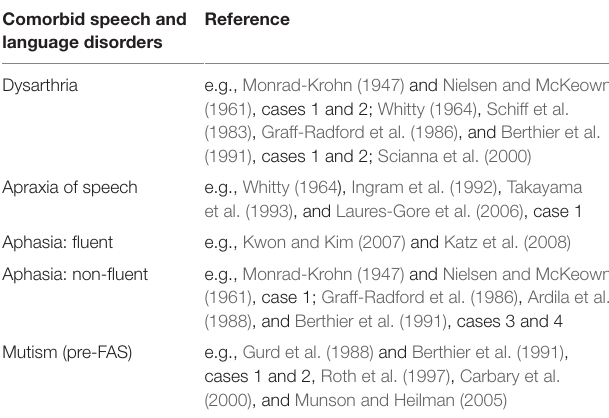
taBLe 2 | overview of the comorbid speech and language disorders in neurogenic Fas cases.